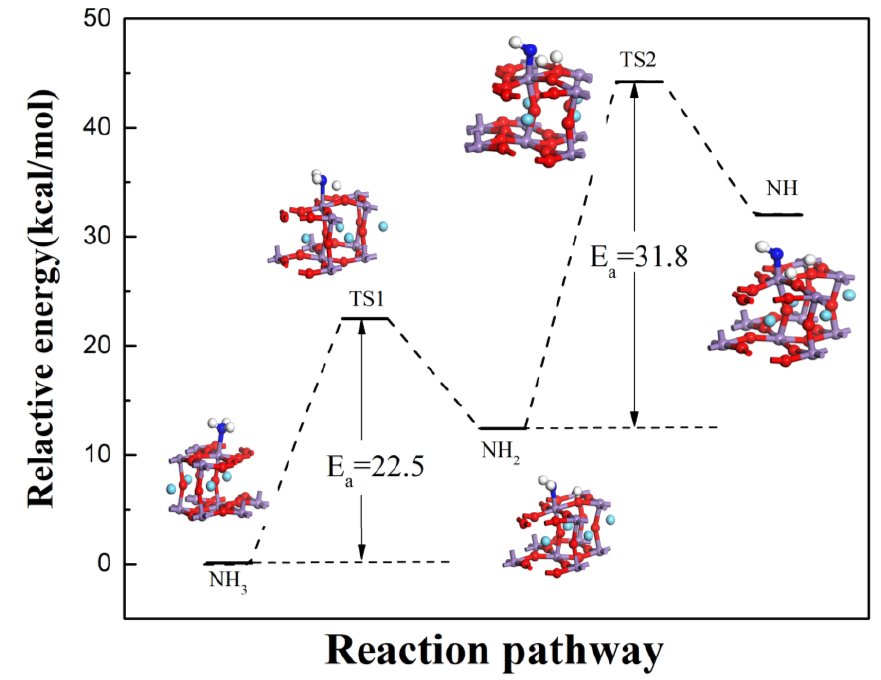
Figure 4. Process of the NH 3 dehydrogenation reaction.